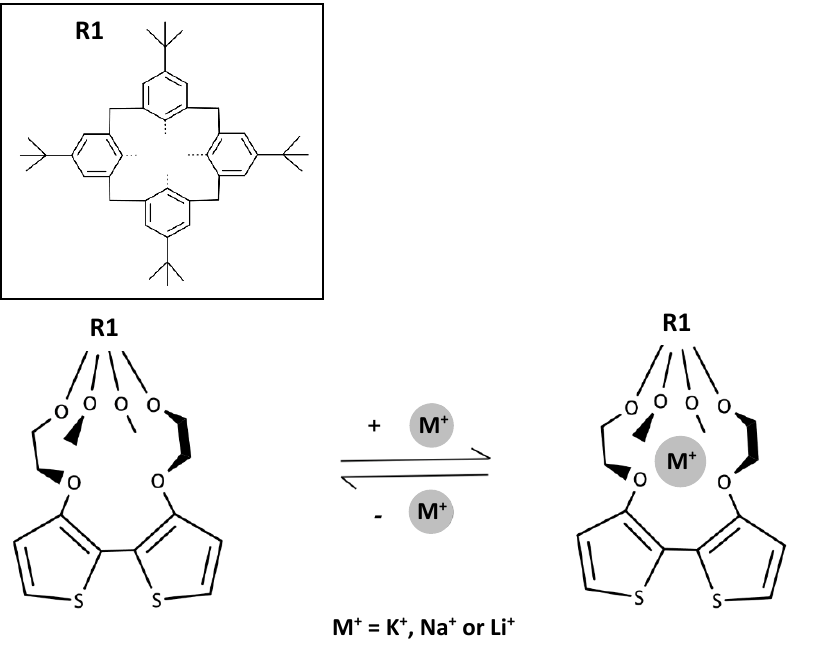
Figure 22. Calixarene modified polythiophene for sensing of alkaline metal cations.